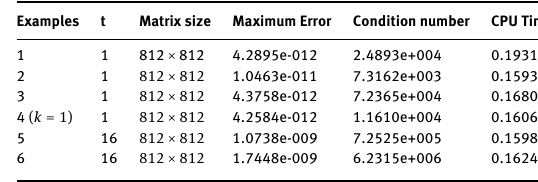
Figure 2: Analytical and approximate solution for example 1 at (a) t = 0.5 and (b) t =